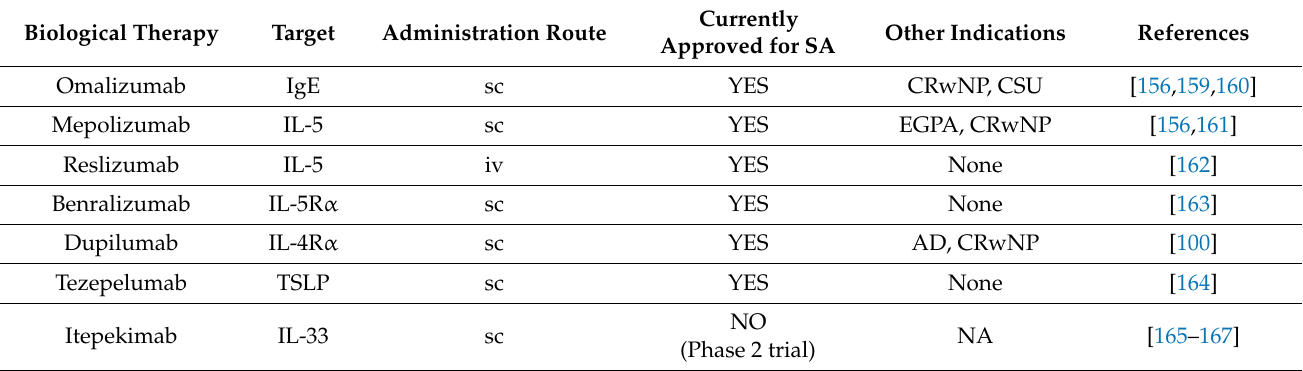
Table 2. Current and future biological therapies for type 2-high severe